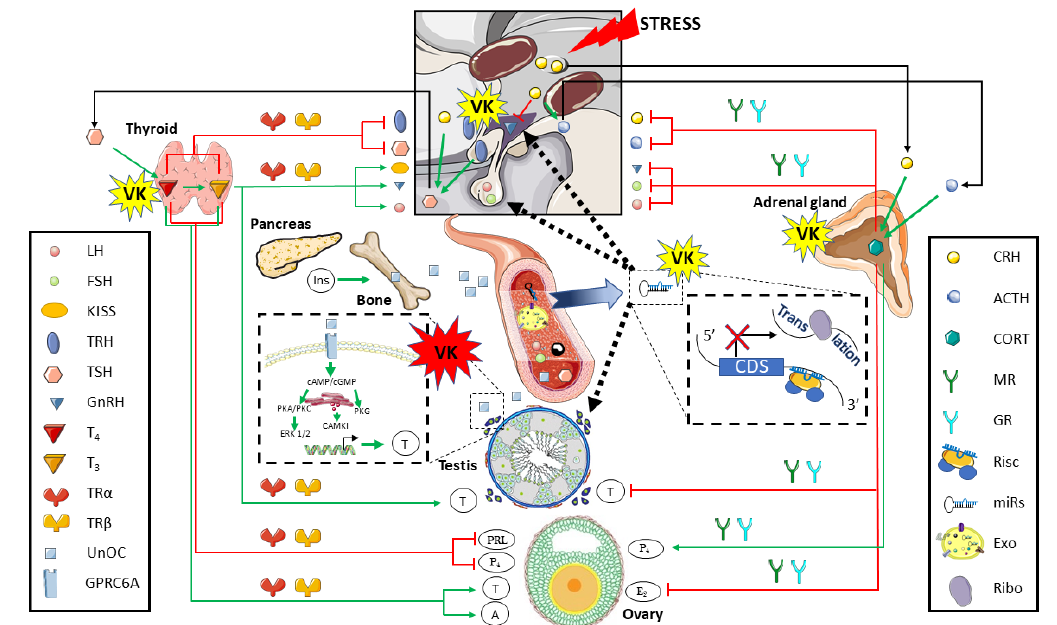
Figure 5. Tissue crosstalk in vertebrate gametogenesis and gamete quality. On the left hand, the crosstalk between the thyroid gland and the pancreas-bone with the hypothalamus-pituitary-thyroid (HPG) axis is depicted. On the right hand, the respective crosstalk between the stress response system and the adrenal gland with the HPG axis is presented, while the crosstalk of HGP and other tissues through the circulating non-coding RNAs (ncRNAs) whether included in exosomes or not is hypothesized. The particular mechanisms by which vitamin K (VK) has a demonstrated effect on reproductive tissue crosstalk are highlighted in red, while those showing potential evidences are highlighted in yellow. A, androgens; ACTH, adrenocorticotropic hormone; CDS, coding sequence; CORT, glucocorticoids; CRH, corticotropin releasing hormone; Exo, exosomes; E 2 , estradiol; D1, deiodinase type 1; D2, deiodinase type 2; D3, deiodinase type 3; FSH, follicle-stimulating hormone; GnRH, gonadotropin-releasing hormone; GPRC6A, G Protein-Coupled Receptor Class C Group 6 Member; GR, glucocorticoid receptor; Ins, insulin; KISS, kisspeptin; LH, luteinizing hormone; miRs, microRNAs; MR, mineraloglucocorticoid receptor; PRL, prolactin; P 4 , progesterone; Ribo, ribosomal subunits; Risc, RNA-induced silencing complex; T, testosterone; TR α , thyroid hormone receptor alpha; TR β , thyroid hormone receptor beta; TRH, thyrotropin-releasing hormone; TSH, thyroid-stimulating hormone; T 4 , 3,5,3 ′ ,5 ′ -tetraiodothyronine; T 3 , 3,5,3 ′ -triiodothyronine; UnOc, uncarboxylated osteocalcin.